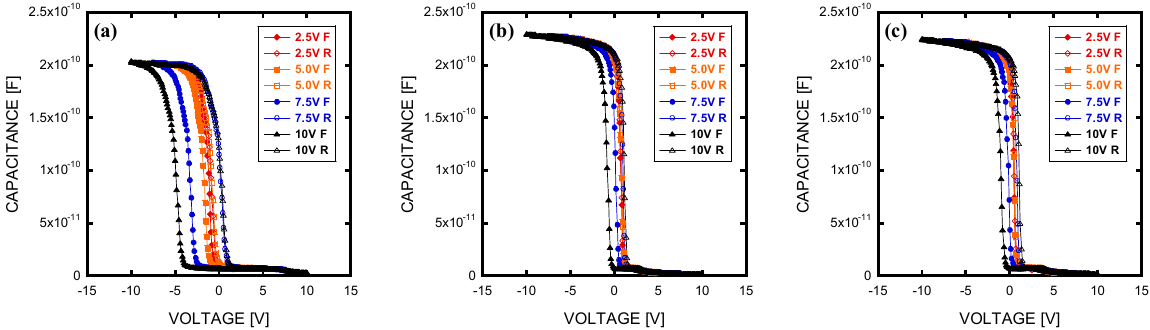
Figure 10. Capacitance–voltage measurements of ALD-based ZrO 2 using CMEN-Zr and oxygen plasma as zirconium and oxygen sources, respectively: ( a ) as-deposited, ( b ) annealed at 500 °C and ( c ) annealed at 600 °C. Table 1. Summarized electrical and dielectric characteristics obtained from the current ZrO 2 and reported ZrO 2 thin films.